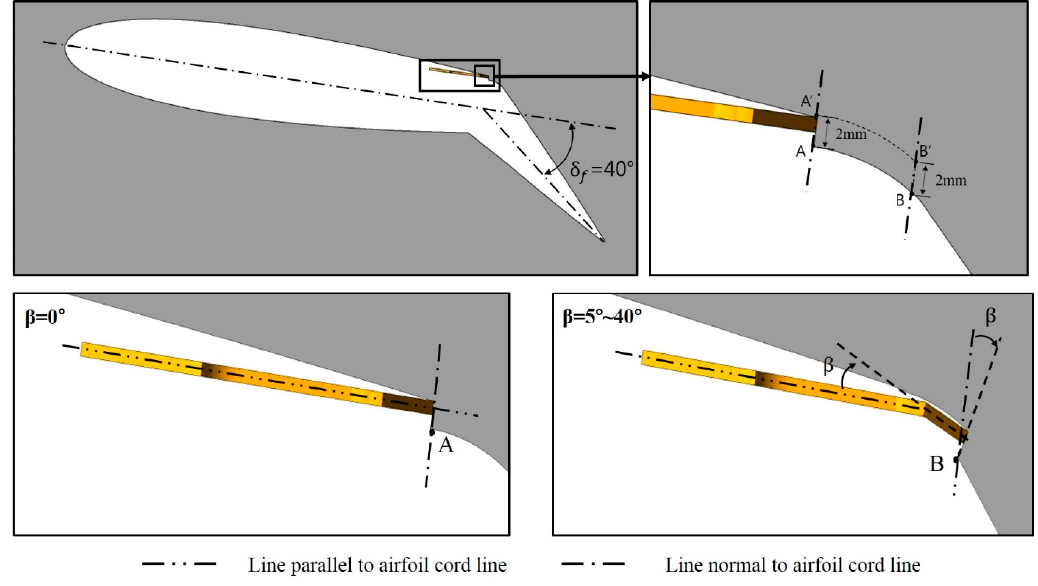
Figure 3. Installation conditions of fluidic oscillators.